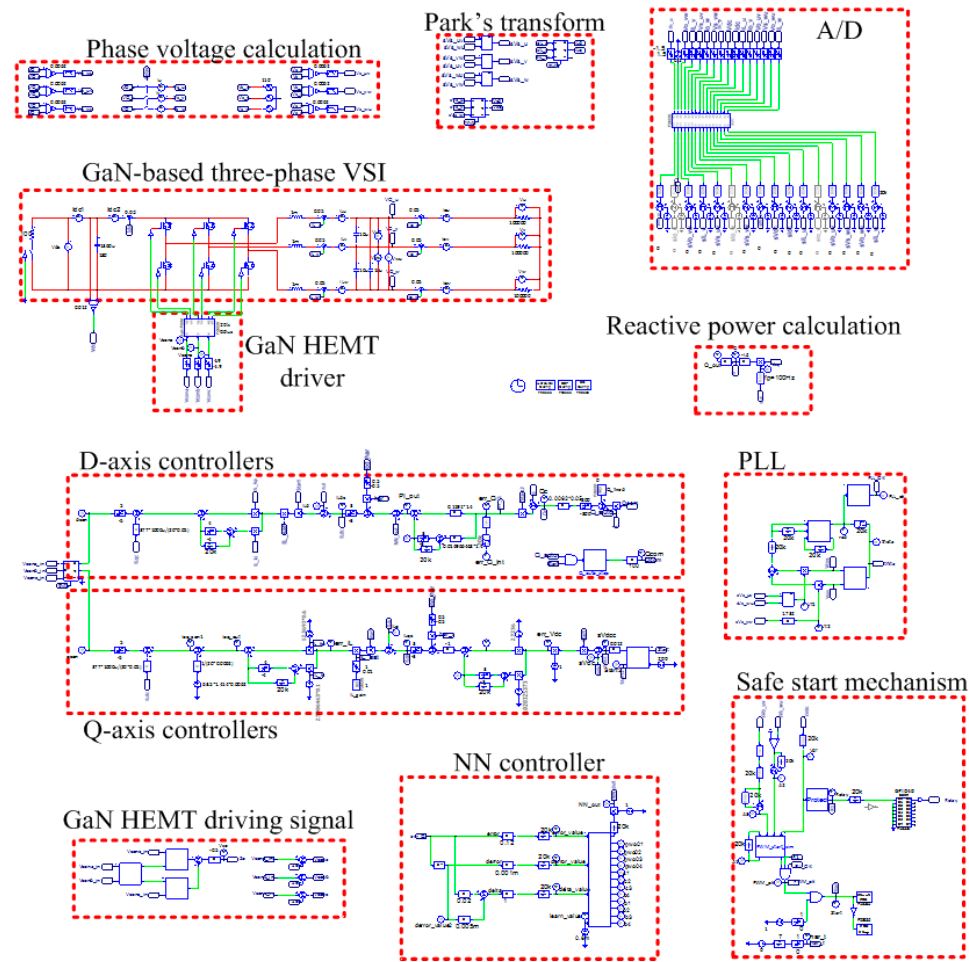
Figure 13. Simulation model in software environment. Table 2. Reactive power controller setting.